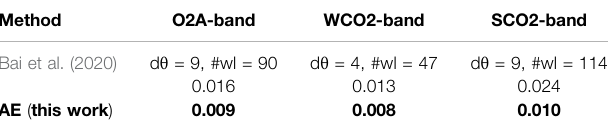
TABLE 1 | Comparison of model error in percent relative to continuum using a correlation-based method to select input wavelengths and using an auto- encoder (AE), as proposed. The number of resulting input wavelengths for each band are indicated with #wl. The parameter d θ is part of the input wavelength selection algorithm described by Bai et al.